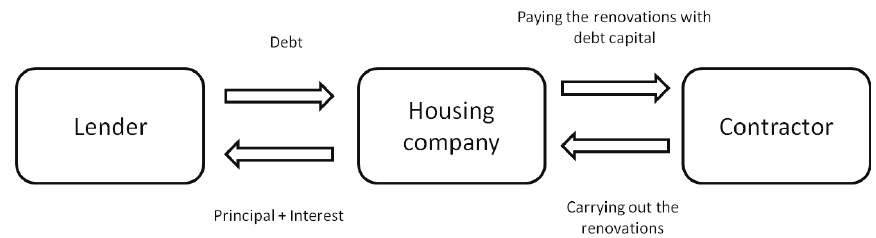
figure 1. Traditional debt financing (after luoma-Halkola et al.,